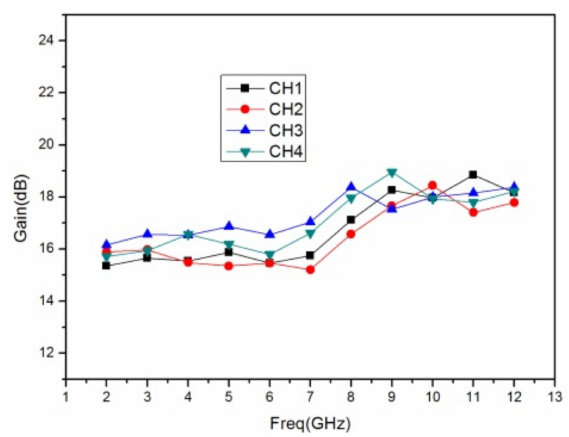
Figure 16. Receive small-signal